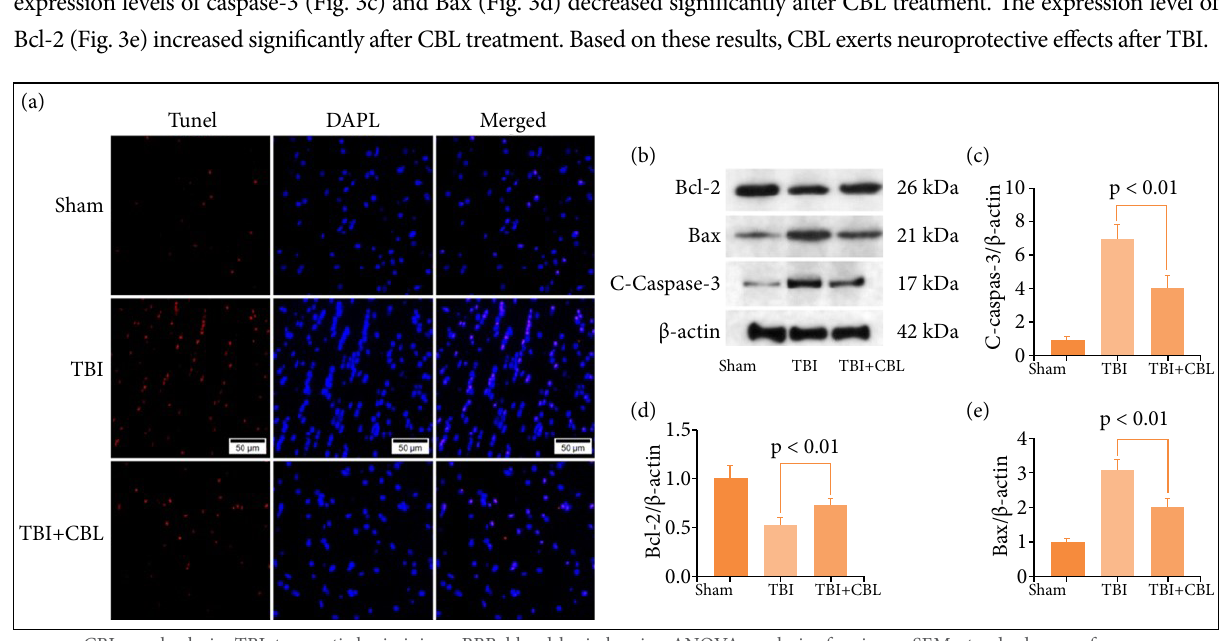
Figure 3 - CBL alleviates brain cortical neuronal apoptosis after TBI. (a) TUNEL staining showed that CBL alleviated neuronal death in the brain cortex 72 h after TBI. (b) The expression of cleaved caspase-3, Bax, and Bcl-2 in the brain cortex of mice after TBI was determined by Western blotting. Quantification of (c) cleaved caspase-3, (d) Bcl-2, and (e) Bax in the brain cortex in response to the β-actin loading control. CBL decreased cleaved caspase-3 and Bax expression in the brain cortex and significantly increased the expression level of Bcl-2 after TBI. p < 0.01. Scale bar = 50 μ m. ANOVA; mean ±